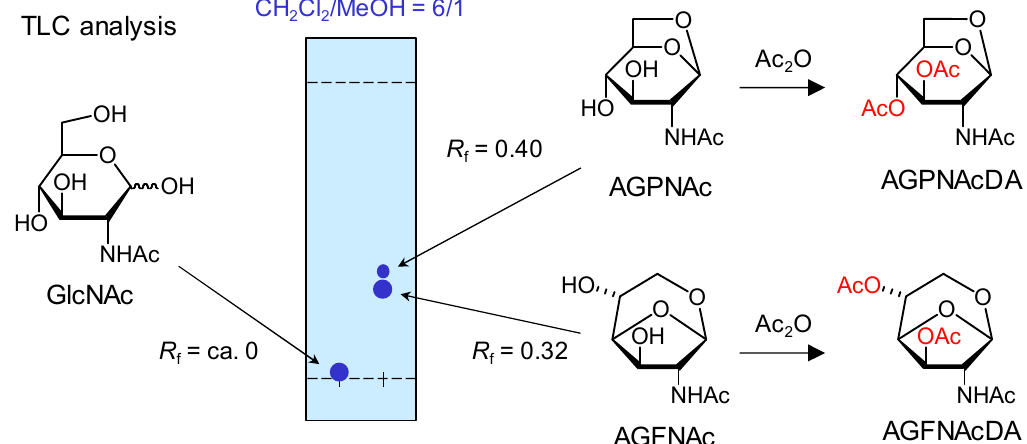
Chart 1. Image for the results of the TLC analyses to explain the reaction features and scheme for acetylation to ensure the molecular assignments.